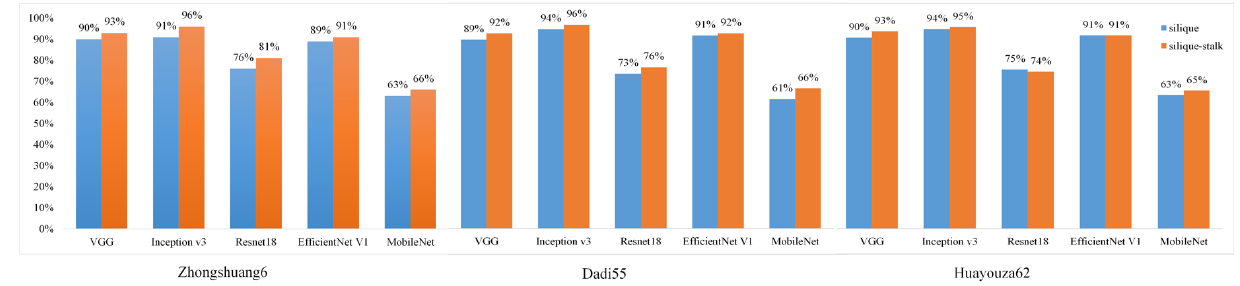
Figure 6. Comparison of silique features and silique-stalk combined features of 3-levels